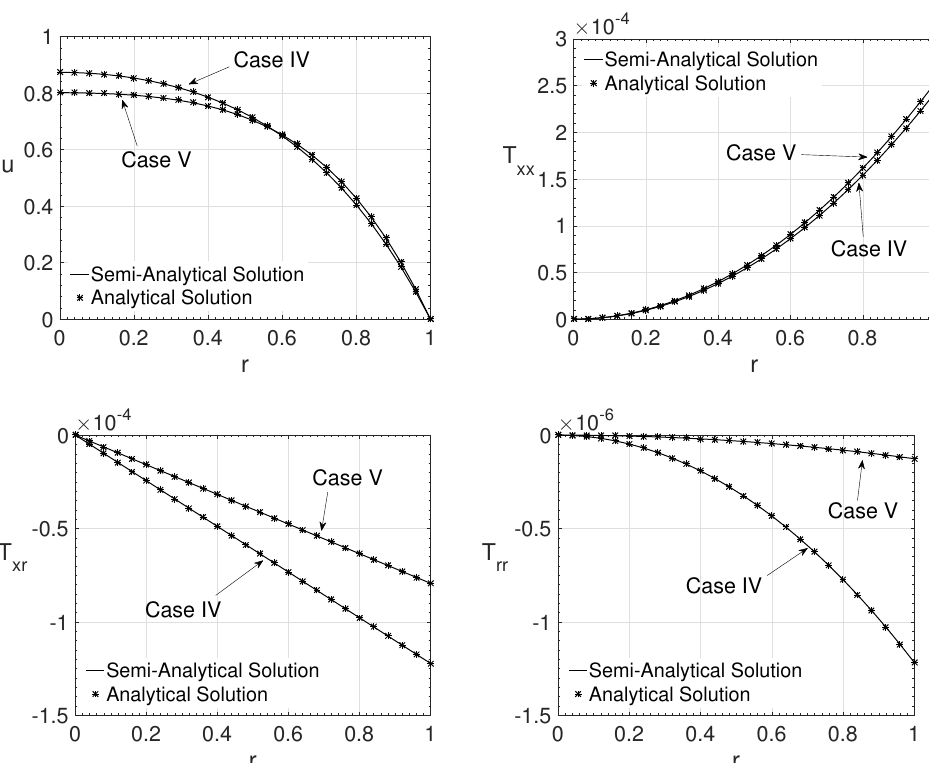
Figure 3. Radial variation r of the streamwise velocity component u and the extra-stress tensor components T xx , T xr and T rr for the cases IV and